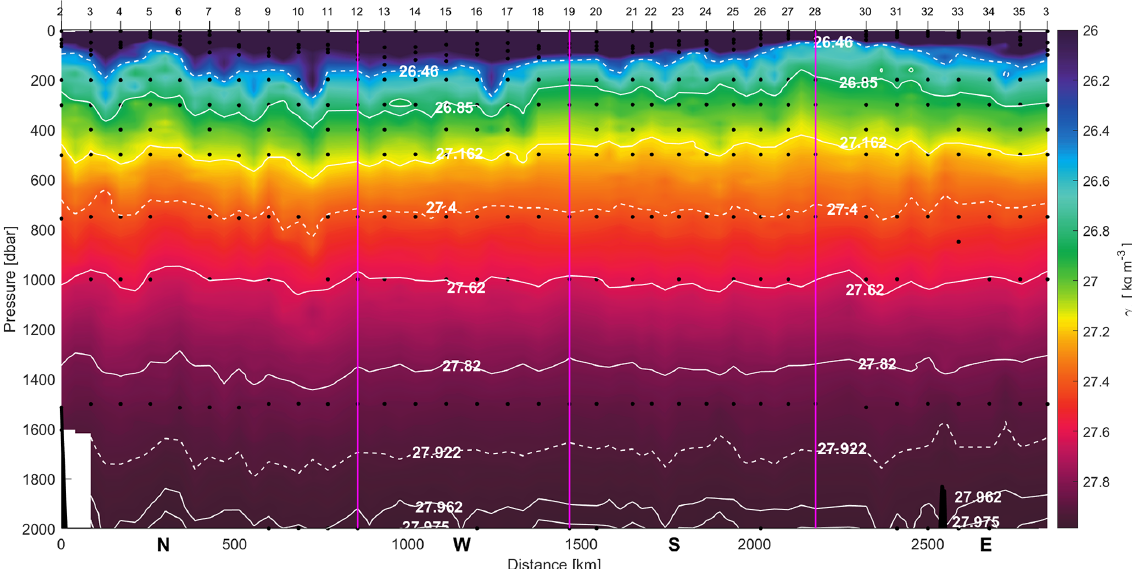
Figure 3. γ n vertical section during the FLUXES-I cruise produced with the CTD–XBT merged dataset. White dashed isoneutrals limit the different water type layers. The direction chosen for the representation of the transects is the course of the vessel. Distance is calculated with respect to the first station (2). The section is divided as follows: transect N from east to west (from station 2 to 12), transect W from north to south (from station 12 to 19), transect S from west to east (from station 19 to 28) and transect E from south to north (from station 28 to 3). The northwestern, southwestern and southeastern corners are indicated by three vertical pink lines at stations 12, 19 and 28, respectively. The sampling points of dissolved oxygen and inorganic nutrients used in this work are represented by black dots.